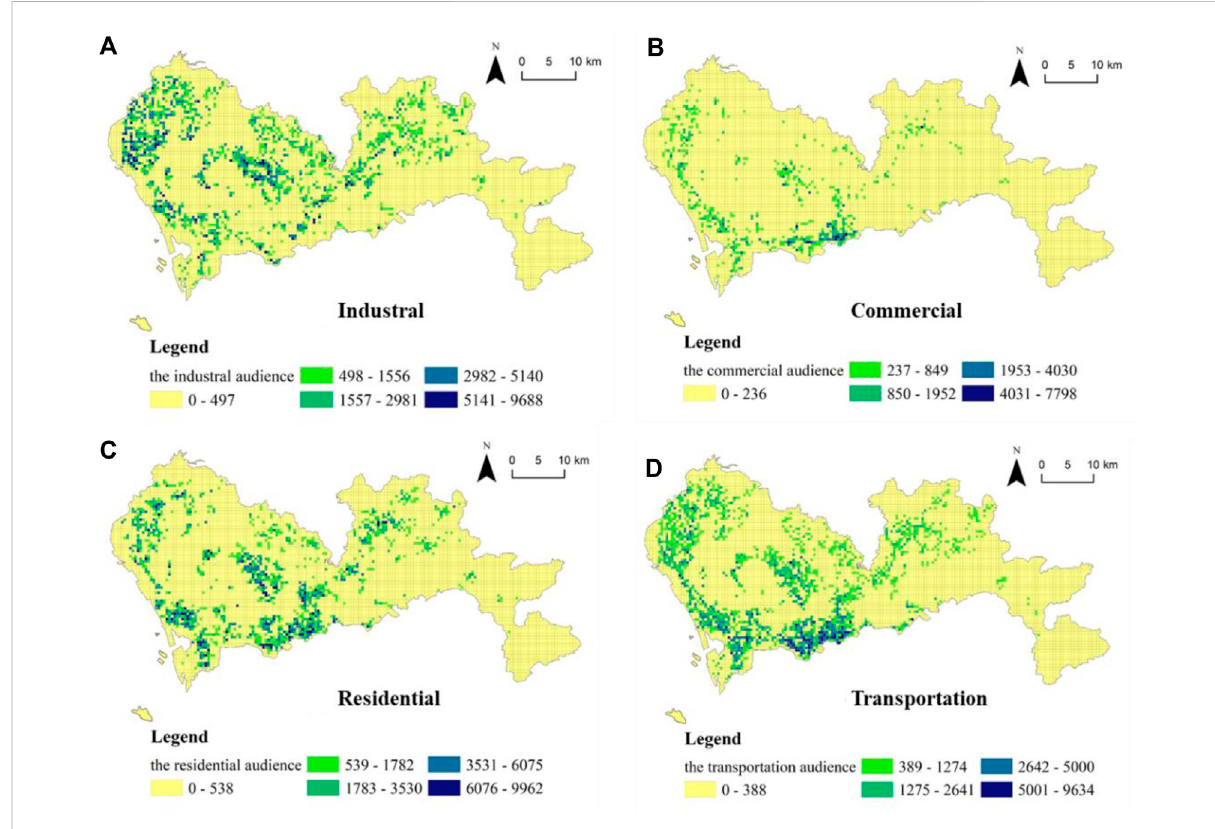
FIGURE 6 Potential target audience distribution for (A) Industral ads, (B) Commercial ads, (C) Residential ads, (D) Transportation